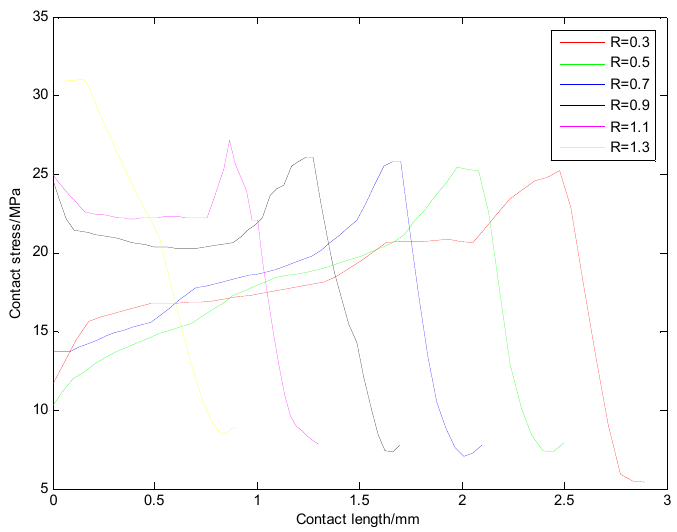
Figure 6. Distribution of the contact stress along contact path I at different chamfering R (mm). It can be seen that under the same working pressure, although the maximum contact stress at I increases with the increase in the chamfer R size, compared with R = 0.3 mm and R = 0.5 mm, the contact pressure F decreases by 8.04%. For the influence of the thickness H of the wear ring, we took the chamfer R as 0.3 mm and width L as 3.5 mm, and defined the thickness H in the range of 1.5 mm to 2.5 mm. The size of each increment was 0.25 mm. The contact stress of I, II, and III sealing surfaces and the maximum Von Mises stress of the combined ring were analyzed. width, maximum contact stress, and position where the maximum stress appeared did not change much.